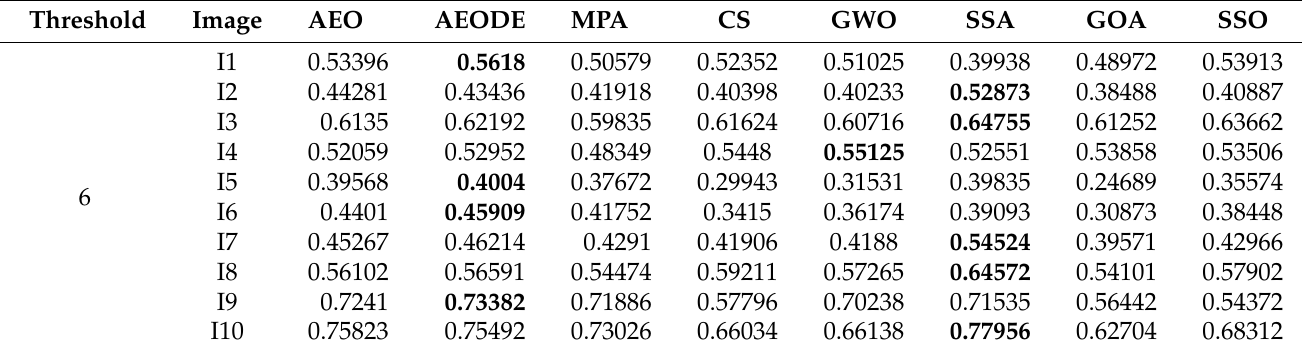
Table 1. SSIM results for all algorithms (bold means the best